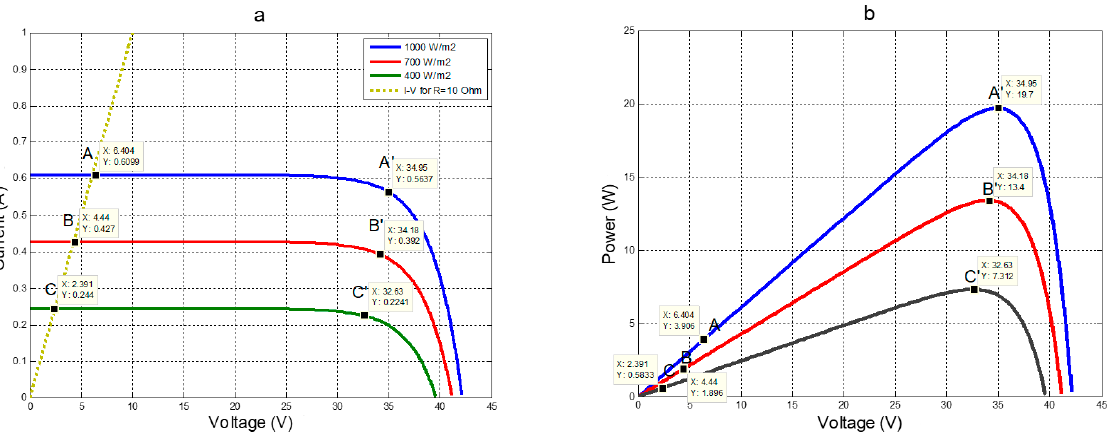
Figure 1. MPP for different insolation on ( a ) current vs. voltage curve and ( b ) power vs. voltage curve.